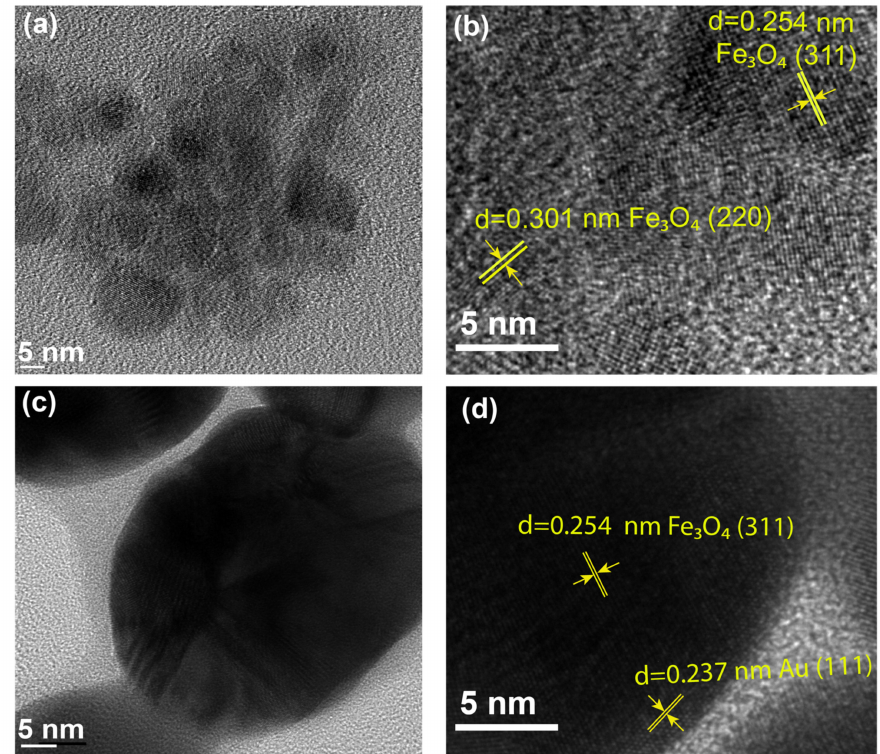
Figure 6. HRTEM image of the Fe 3 O 4 NPs ( a ) with the determined d spacing ( b ). HRTEM image of the 3:200 GMPs ( c ) with the determined d spacing, and ( d ) 3:200 GMPs respectively selected from parts ( a , c ) with scale bar at 5 nm. All images have 5 nm scale